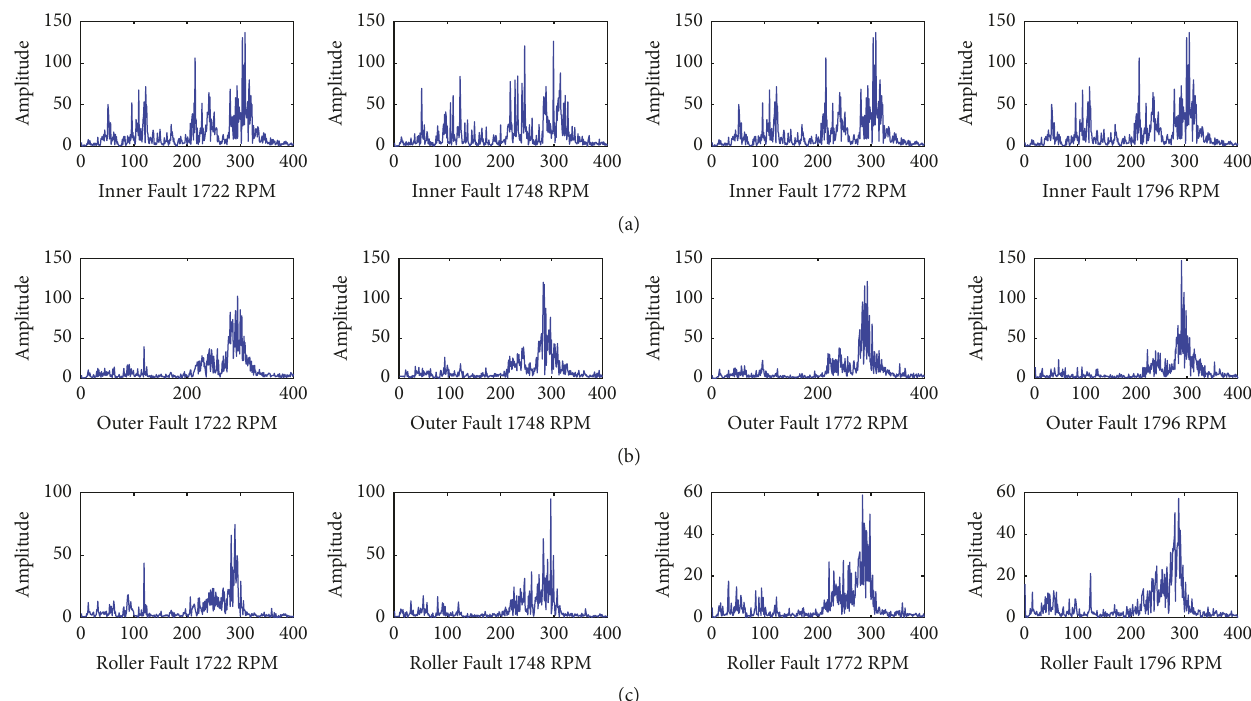
Figure 7: The complex envelope spectra of an (a) inner raceway fault, (b) outer raceway fault, and (c) roller fault signals for various shaft speeds.